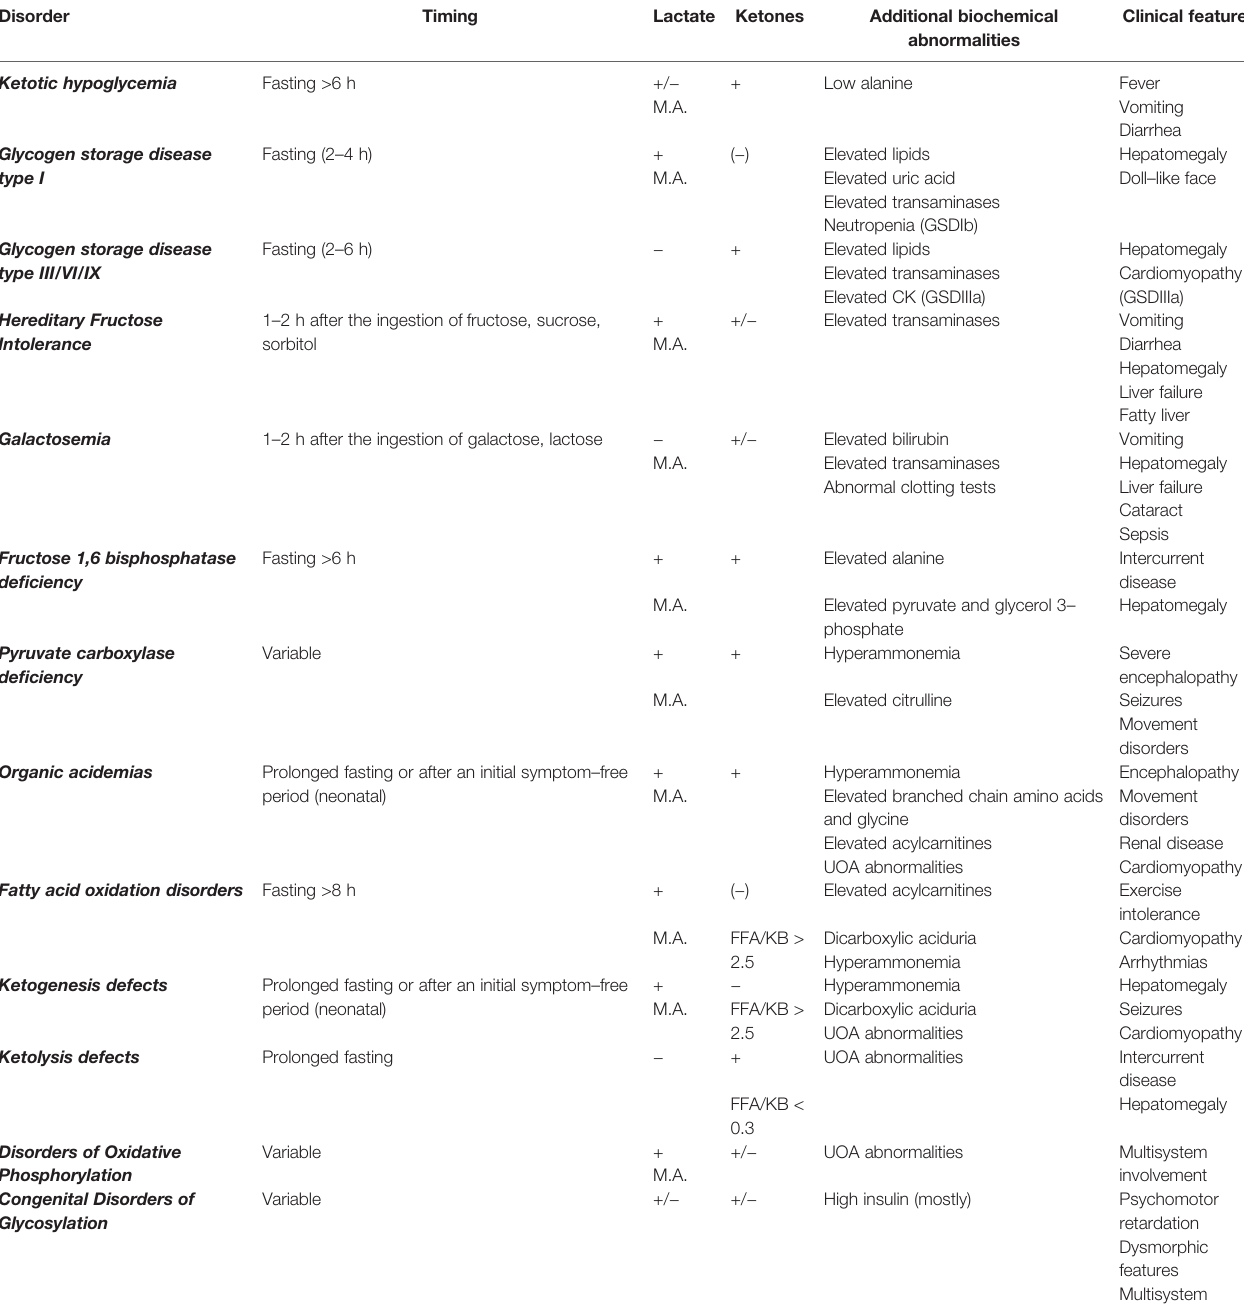
TABLE 6 | Main clinical and biochemical features of major metabolic causes of childhood